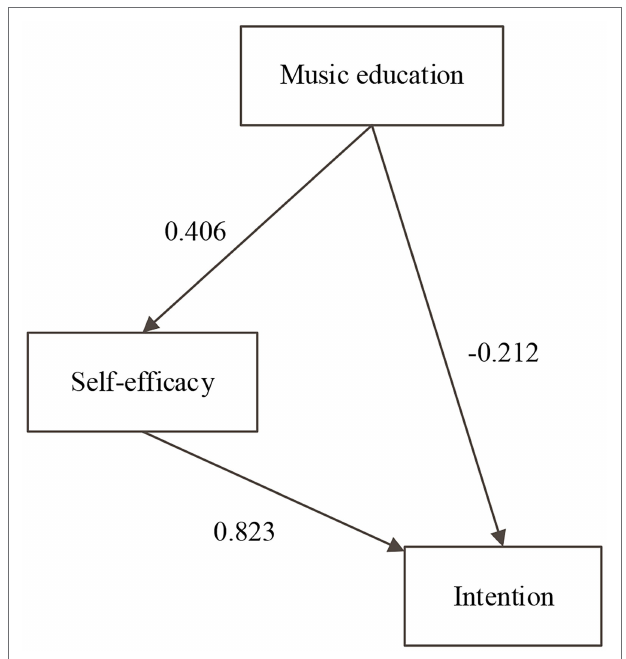
FIGURE 5 | Equation model